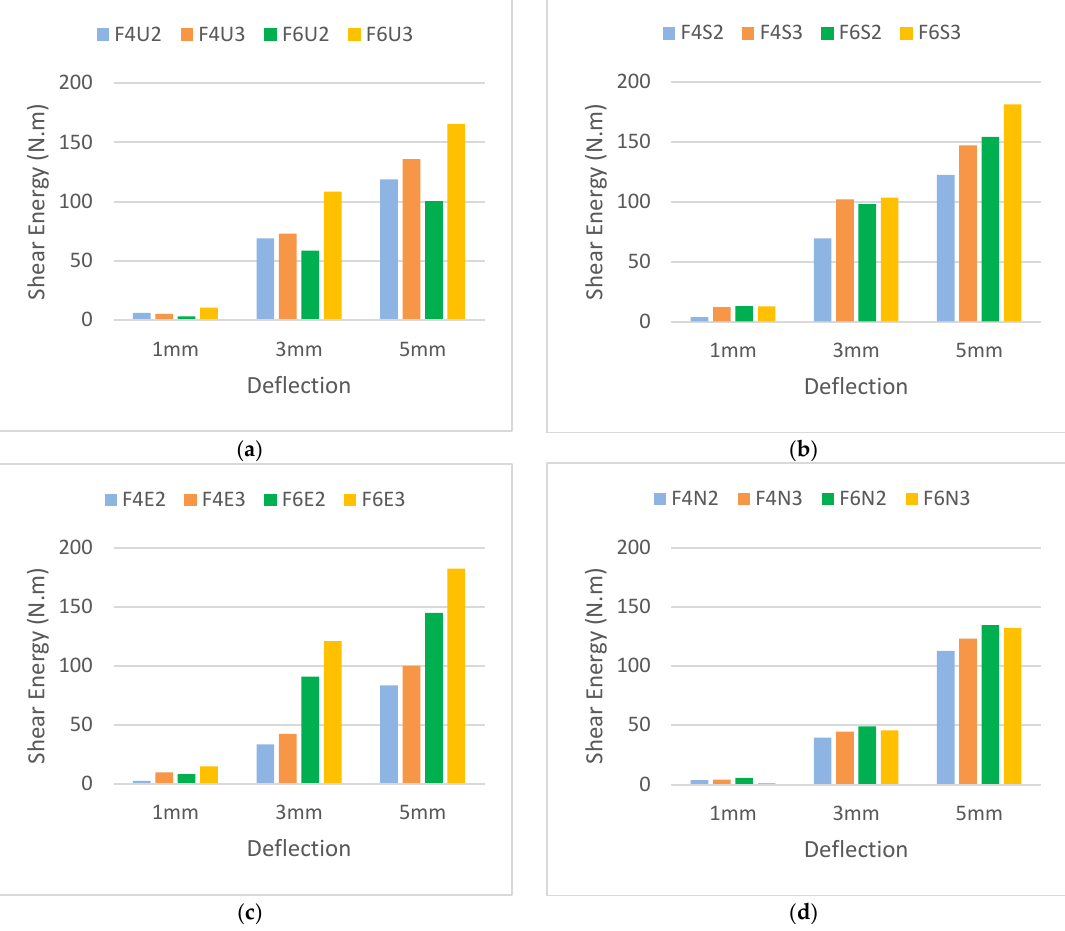
Figure 7. The shear energy absorption capacity for the ( a ) Ferro-Ultra, ( b ) Ferro-Super, ( c ) Ferro-Econo, and ( d ) Ferro-Nylo hybrid.